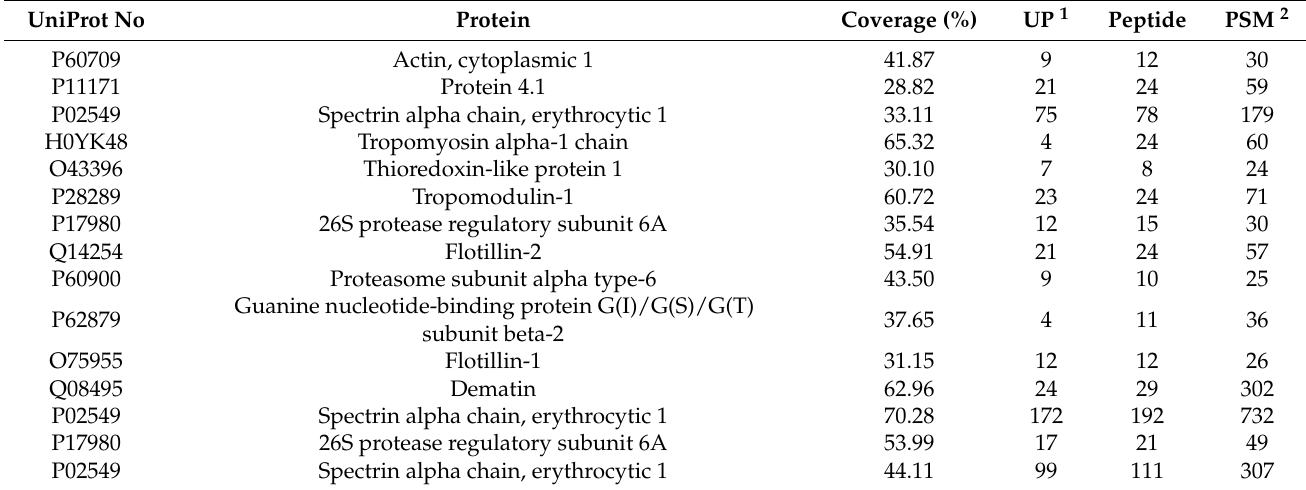
Table 1. Proteins identified by mass spectrometric analysis. Selected proteins are in bold.